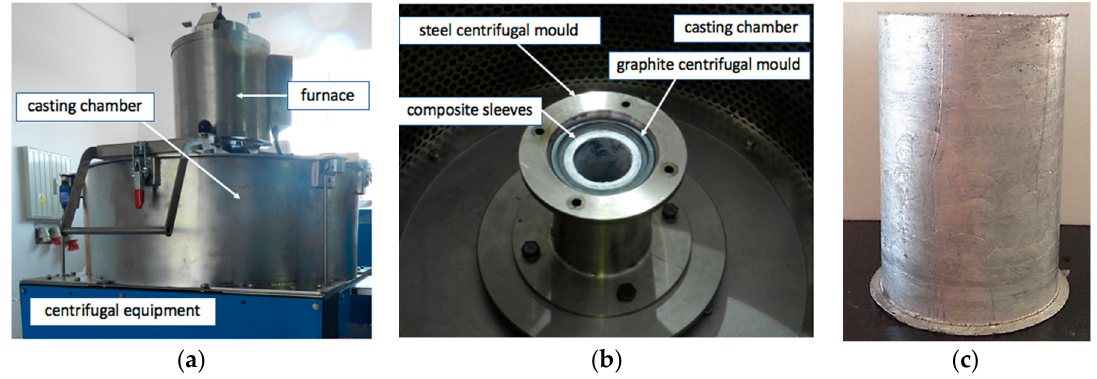
Figure 4. View of technological equipment (MOV500) used in the centrifugal casting process ( a ); Chamber with a visible centrifugal mold ( b ); Representative cast of composite sleeves ( c ).